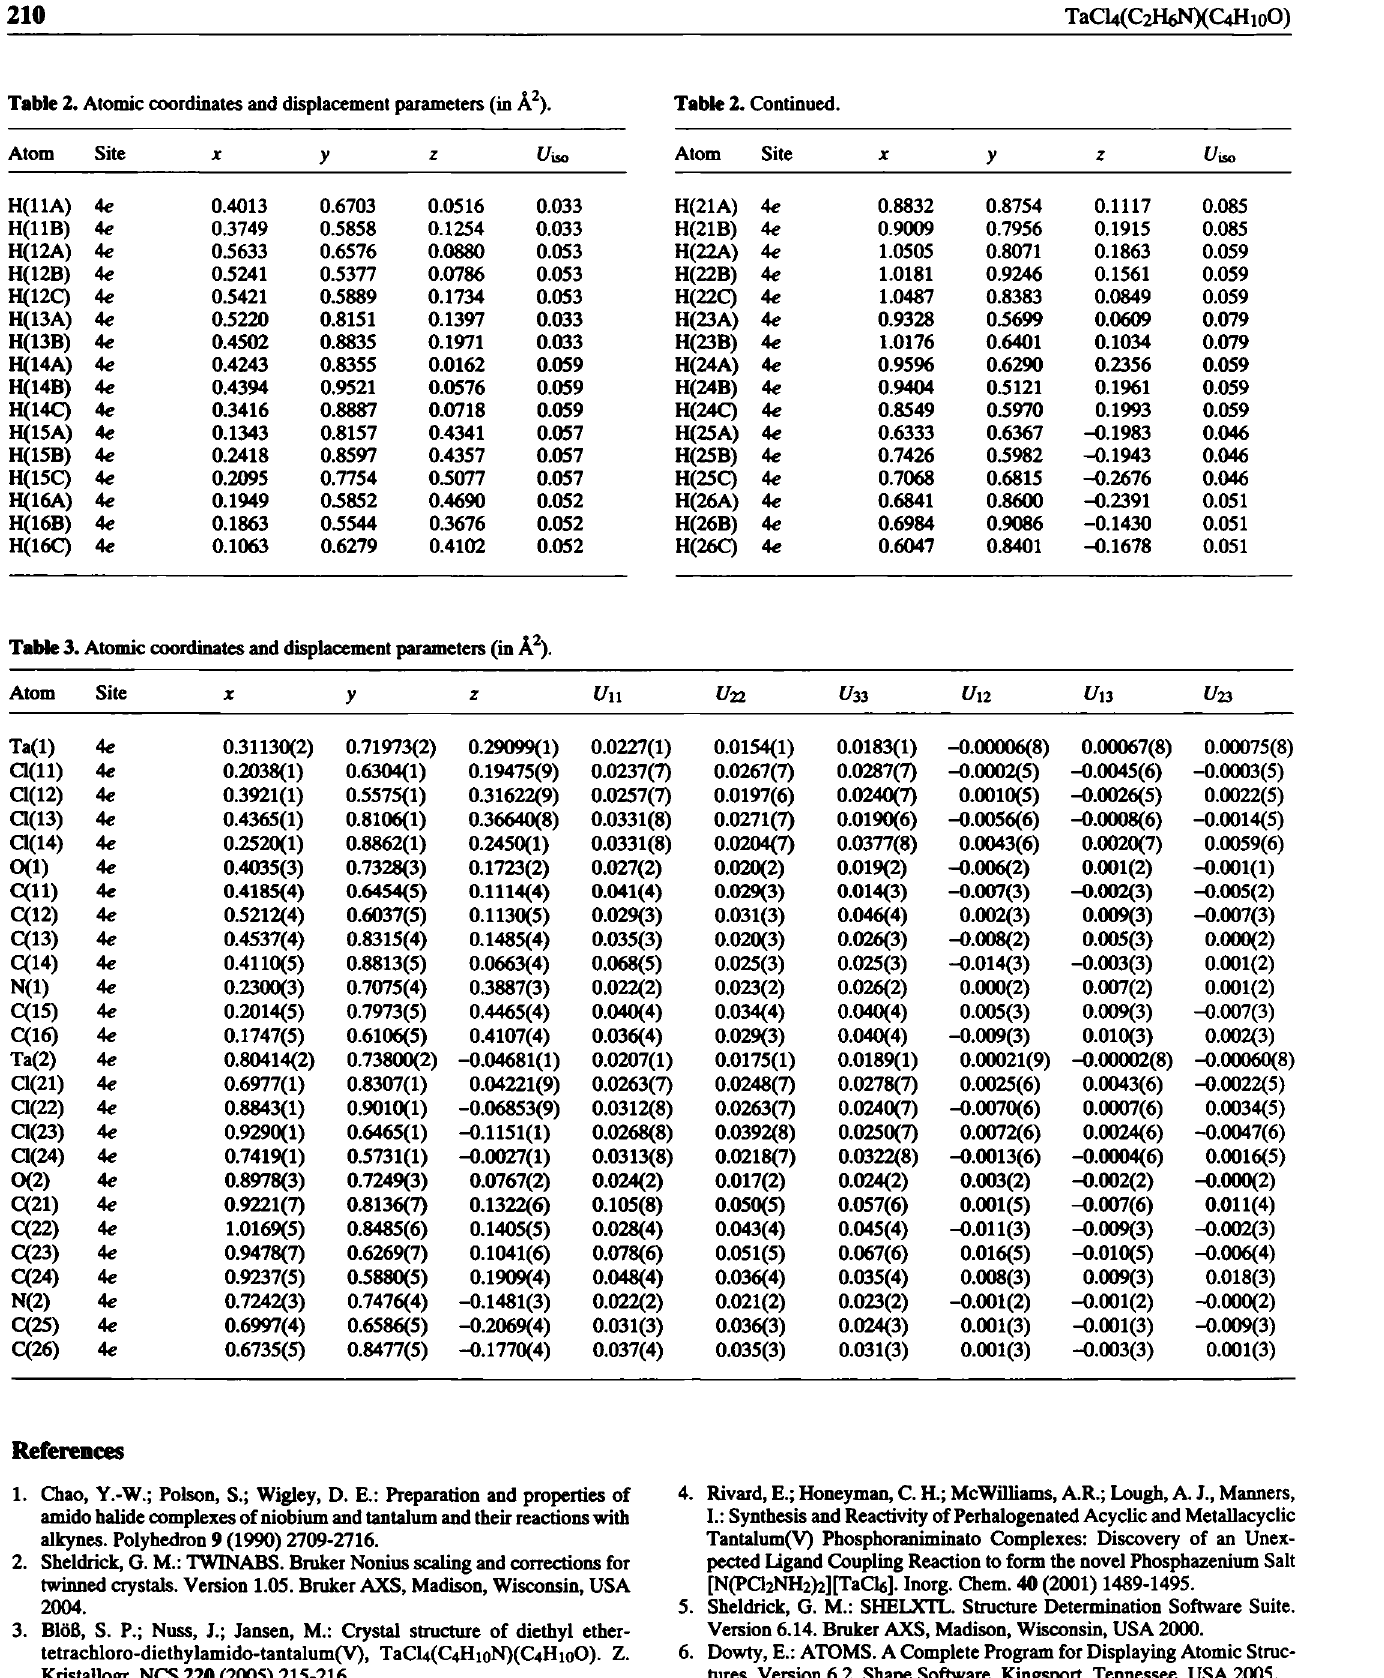
Table 2. Atomic coordinates and displacement parameters (in Ä 2 ).